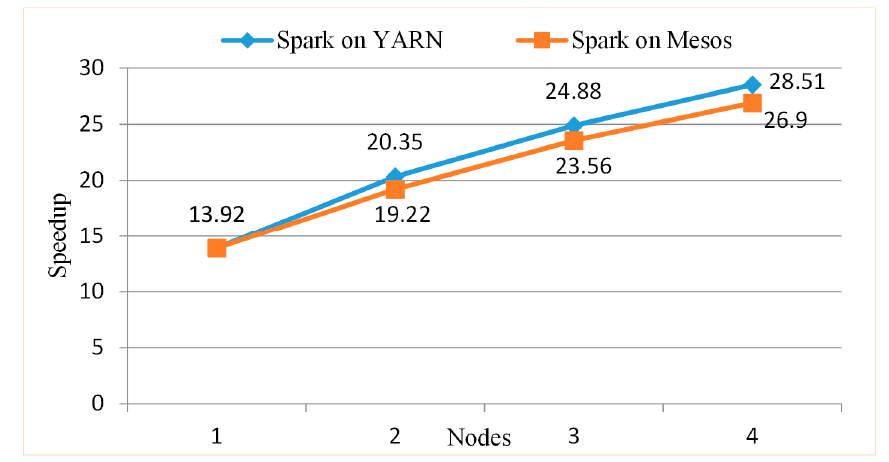
Figure 22. Performance comparison of Yarn and Mesos resources manager.